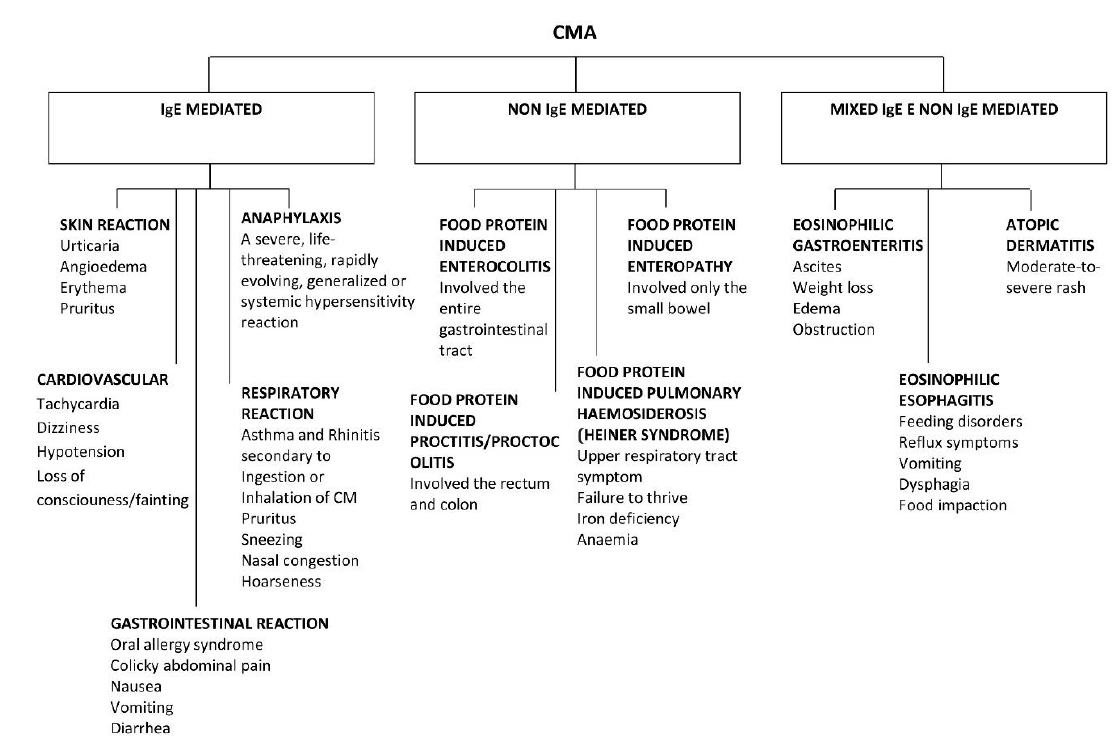
Figure 1. Clinical presentation of IgE and non IgE CMA.